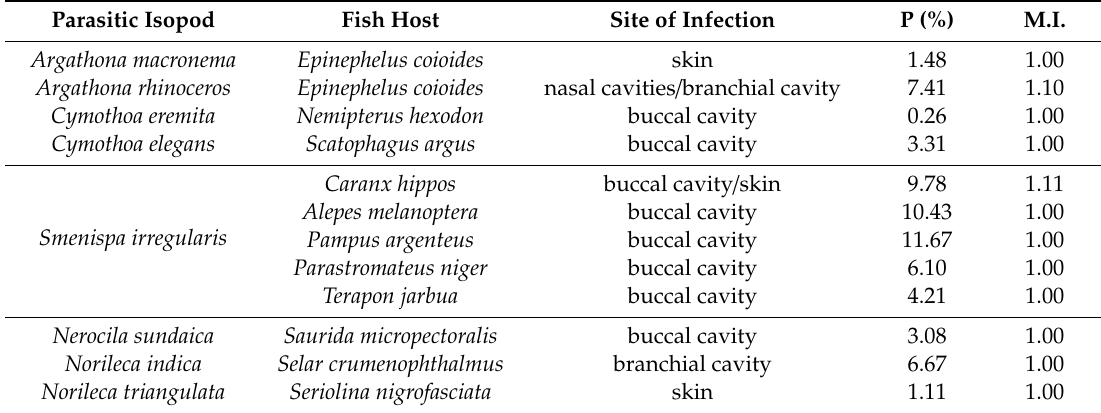
Table 2. Parasitic isopod and their fish host with site of infection, prevalence (P) and mean intensity (M.I.) from the Gulf of Thailand (in this